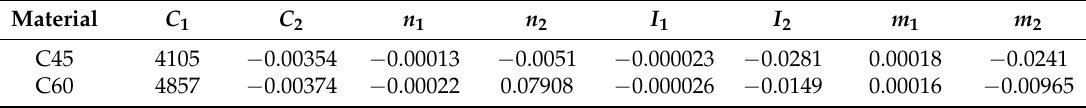
Table 2. Constant of the C45 and C60 grade steel material models.